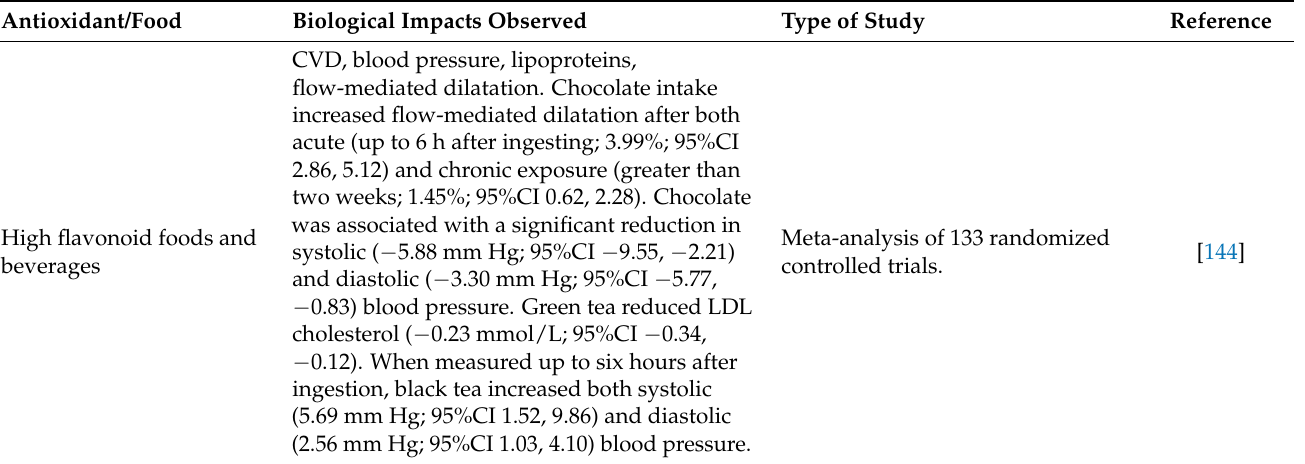
Table 5. Parameters and pertinent results from cited studies examining health outcomes associated with dietary flavonoids and isoflavonoids. HR = Hazard risk, OR = Odds Ratio, CVD = cardiovascular disease, CHD = coronary heart